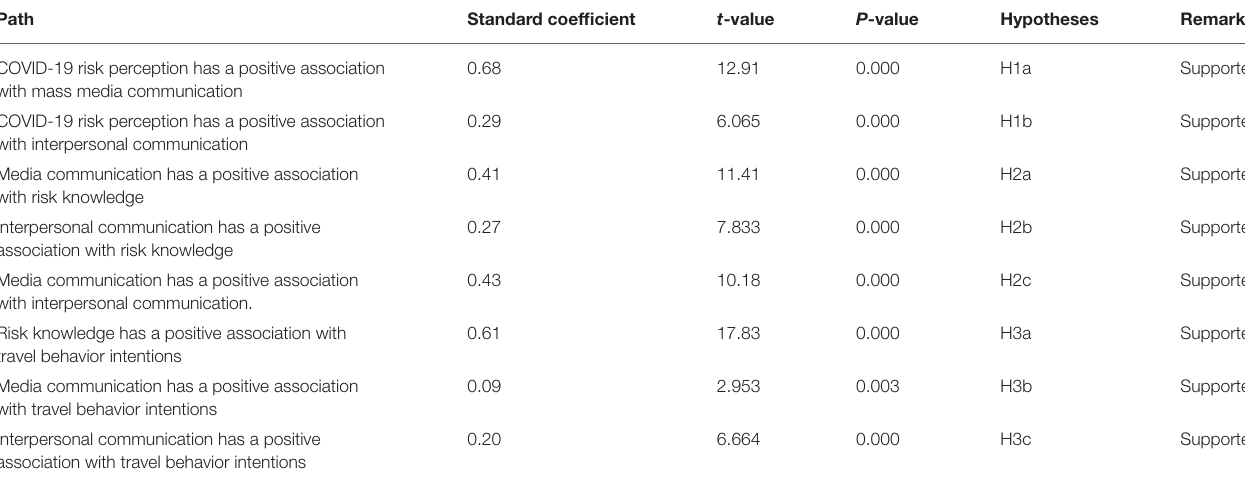
TABLE 5 | Path analysis.